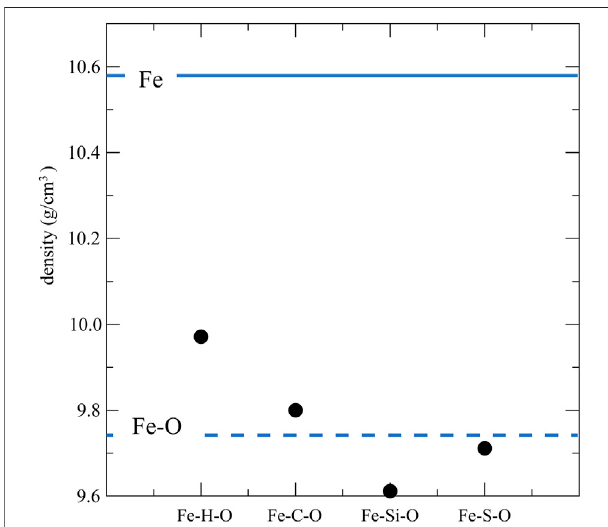
FIGURE 1 | Densities of liquid Fe 160 H 20 O 20 (Fe – H – O), Fe 160 C 20 O 20 (Fe – C – O), Fe 160 Si 20 O 20 (Fe – Si – O), and Fe 160 S 20 O 20 (Fe – S – O) at 140 GPa and 5000 K. Densities of liquid Fe and Fe 160 O 40 (Fe – O) at 140 GPa and 5000 K are also displayed as solid and dashed lines, respectively.